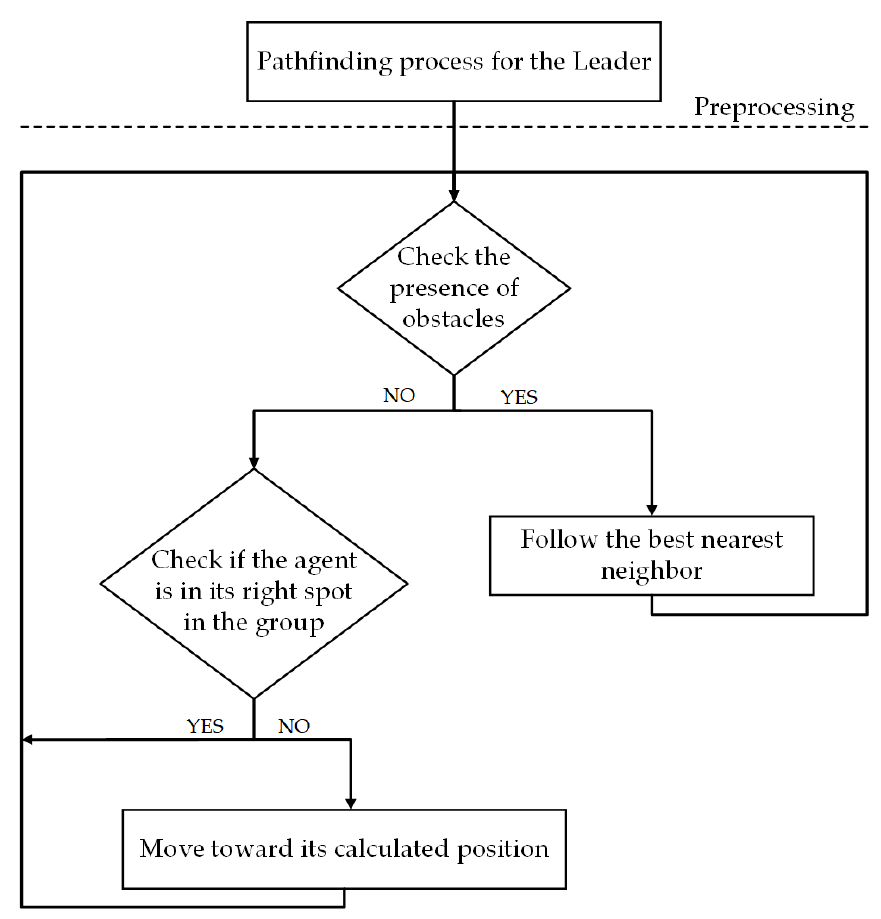
Figure 1. The flowchart of the Discretionary Group Behavior (DGB) algorithm. The preprocessing step happens once and the other parts repeat in each time